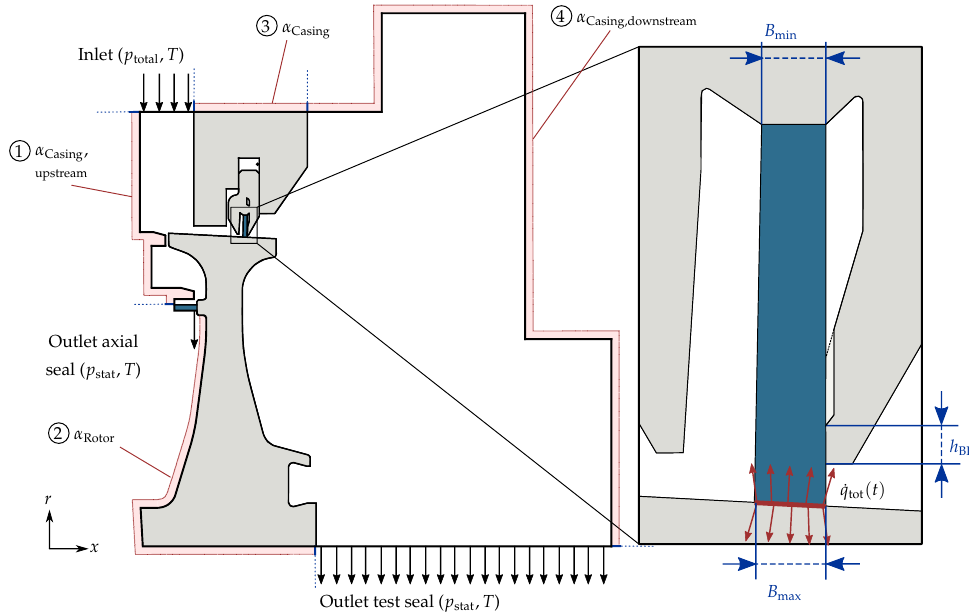
Figure 1. Computational doma in of the numerical model; Fluid ( ), Solid ( ), Porous media (